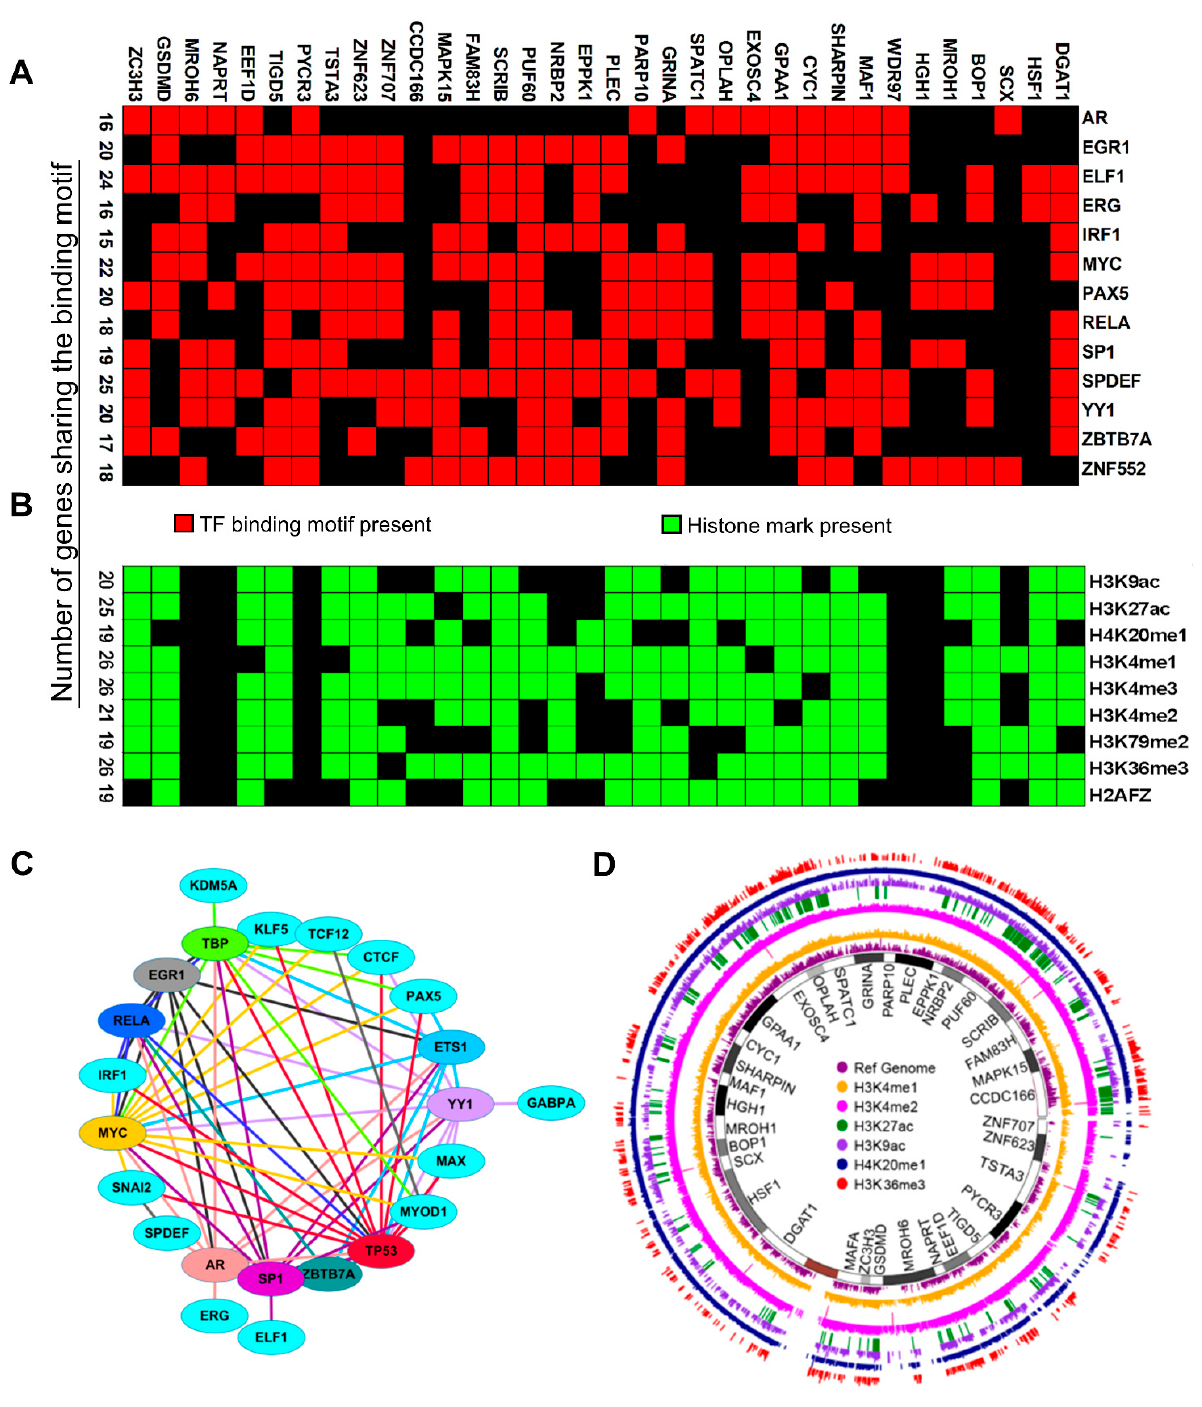
Figure 7. Shared regulatory elements of CanCord34 genes. ( A ) Shared transcription factors associated with the CanCord34 genes within 1 kb from the TSS. ( B ) A cluster matrix showed the activating histone marks shared by the CanCord34 genes in MCF-7 cells. ( C ) Interactions and heterodimerization of TFs with the base TFs (in which interacting response elements are present) in CanCord34 genes. ( D ) Histone mark enrichment analysis of CanCord34 genes and the status of activated histone marks, represented as a Circos plot.